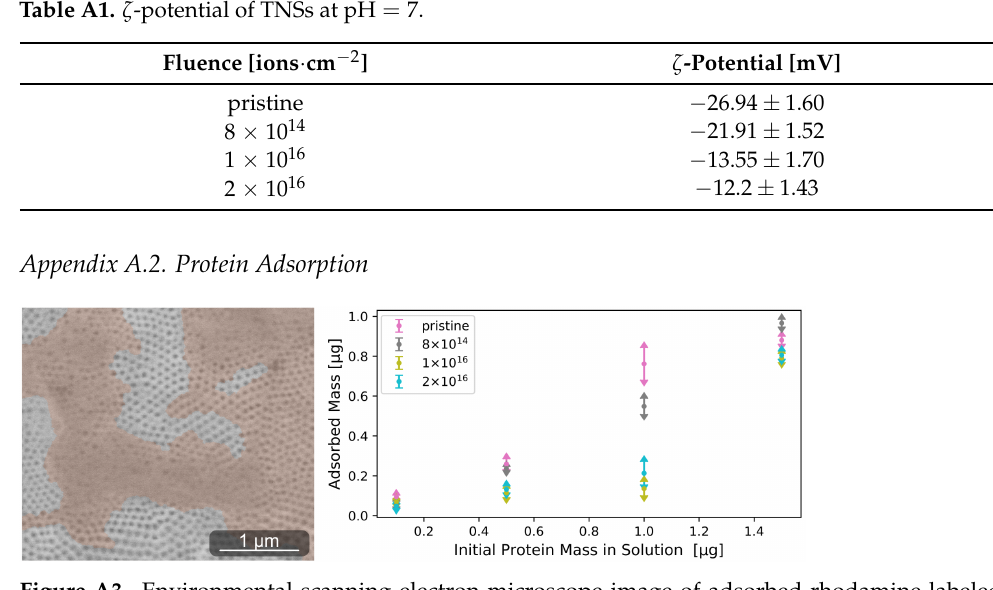
Figure A3. Environmental scanning electron microscope image of adsorbed rhodamine-labeled laminin cluster on pristine TNSs ( left ). Proteins were subsequently stained orange. Adsorbed amount of laminin determined after 30 min for four different initially applied protein concentrations ( right ). On all TNSs, increasing the protein mass in solution leads to a higher amount of adsorbed proteins. Elevating Cfluence results in impediment to protein